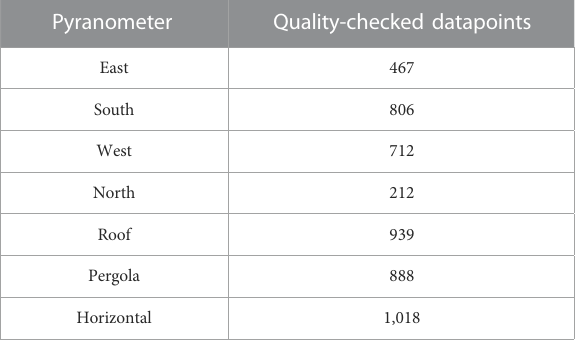
TABLE 6 Datapoints after the application of the quality check